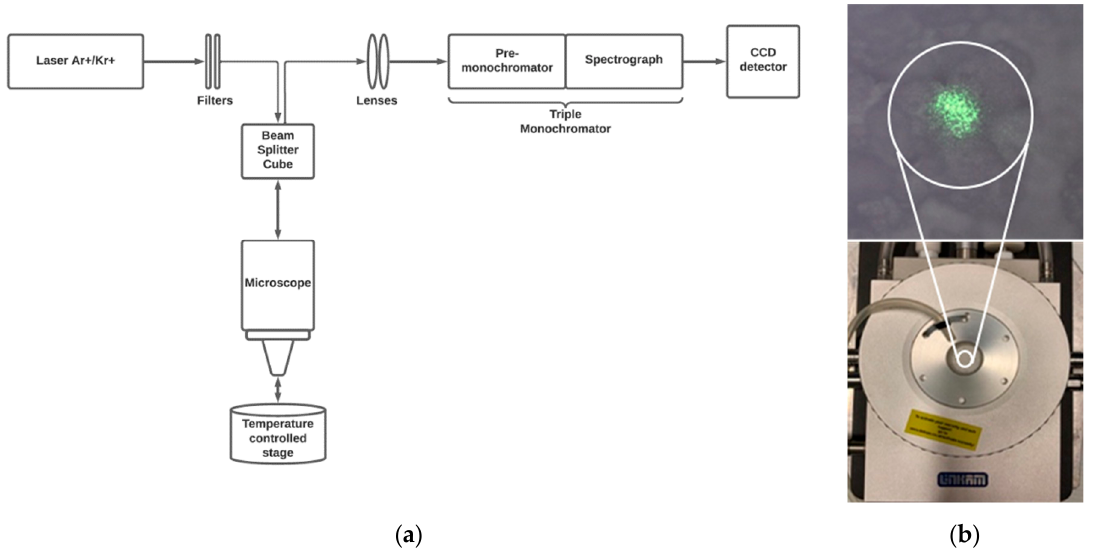
Figure 1. Experimental micro-Raman setup ( a ) and Linkam THMS600/720 temperature-controlled stage with zoom on the sample inserted, showing the laser spot ( b